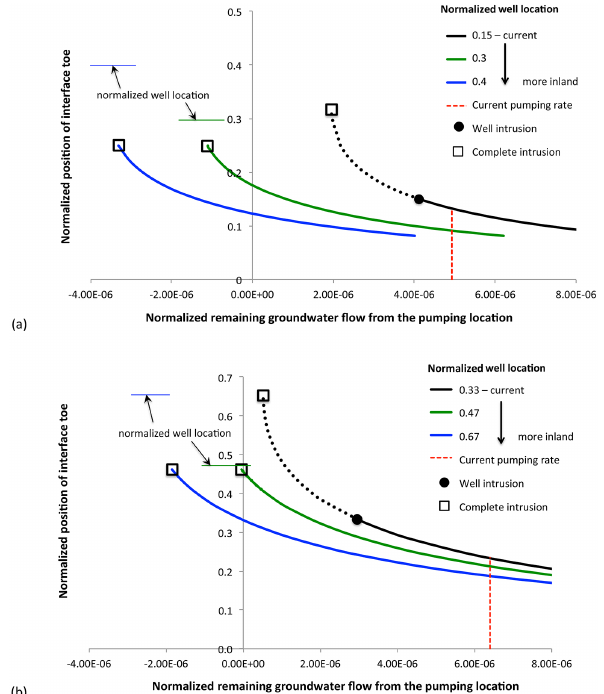
Fig. 6. Seawater intrusion performance curves for different normal- ized locations of the well gallery in (a) the Israel Coastal aquifer (ICA) and (b) the Cyprus Akrotiri aquifer (CAA). Normalized in- trusion toe position, l T / L , is shown as a function of the normal- ized remaining groundwater flow q norm = − ( q o + q w ) /(KL) from the normalized pumping location l w / L ; q norm > 0 when pumping is from l > l w and q norm < 0 when pumping is also from the region between the well and the pumping location. Dimensional l w values for the curves shown here are then 3km (black line; current con- dition), 6km (green line) and 8km (blue line) for ICA, and 1km (black line; current condition), 1.4km (green line) and 2km (blue line) for CAA. Black dotted line: continued pumping of